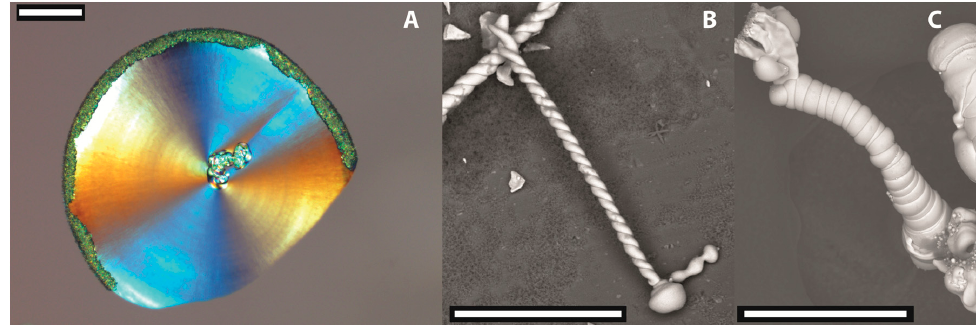
Figure 1. Polarised light microscopy (PLM) and SEM images of the most common architectures displayed by silica biomorph structures grown at room temperature from solutions containing 8.9 mM silica and 5 mM barium chloride: ( A ) flat sheet, ( B ) regular helicoid, ( C ) tightly wound worm. Scale bars are 100 µ